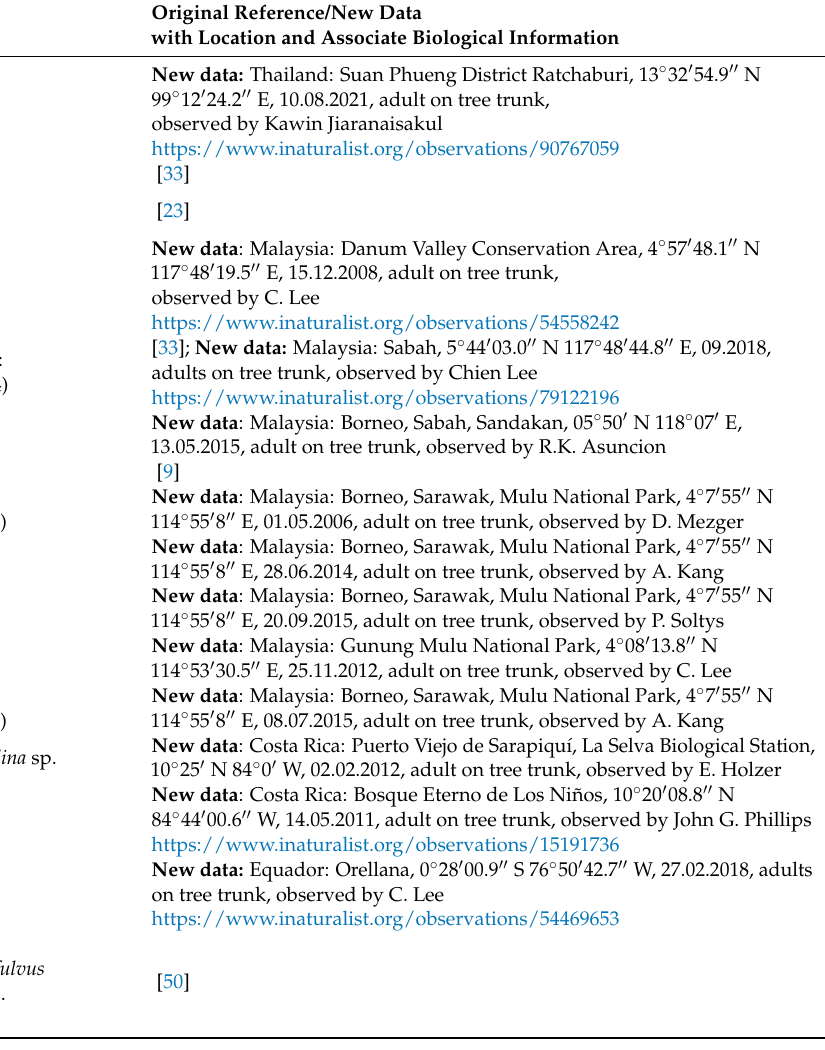
Fulgoromorpha Trophobiont Species